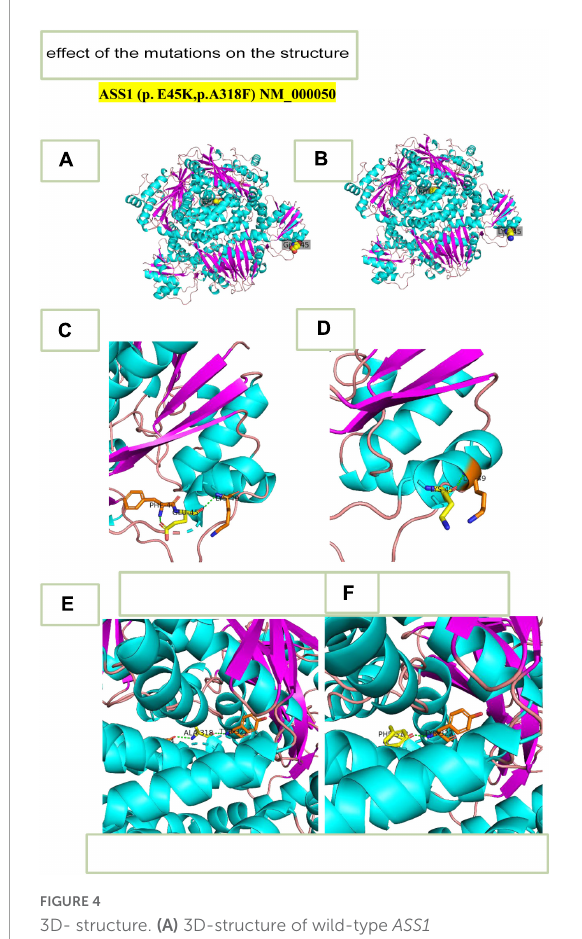
FIGURE4 3D- structure. (A) 3D-structure of wild-type ASS1 (p.E45K,p.A318F). (B) 3D structure of mutation ASS1 (p.E45K,p.A318F). (C) 3D-structure of wild-type ASS1 (p.E45K). (D) 3D structure of mutation type ASS1 (p.E45K). (E) 3D structure of wild-type ASS1 (p.A318F). (F) 3D structure mutation type ASS1